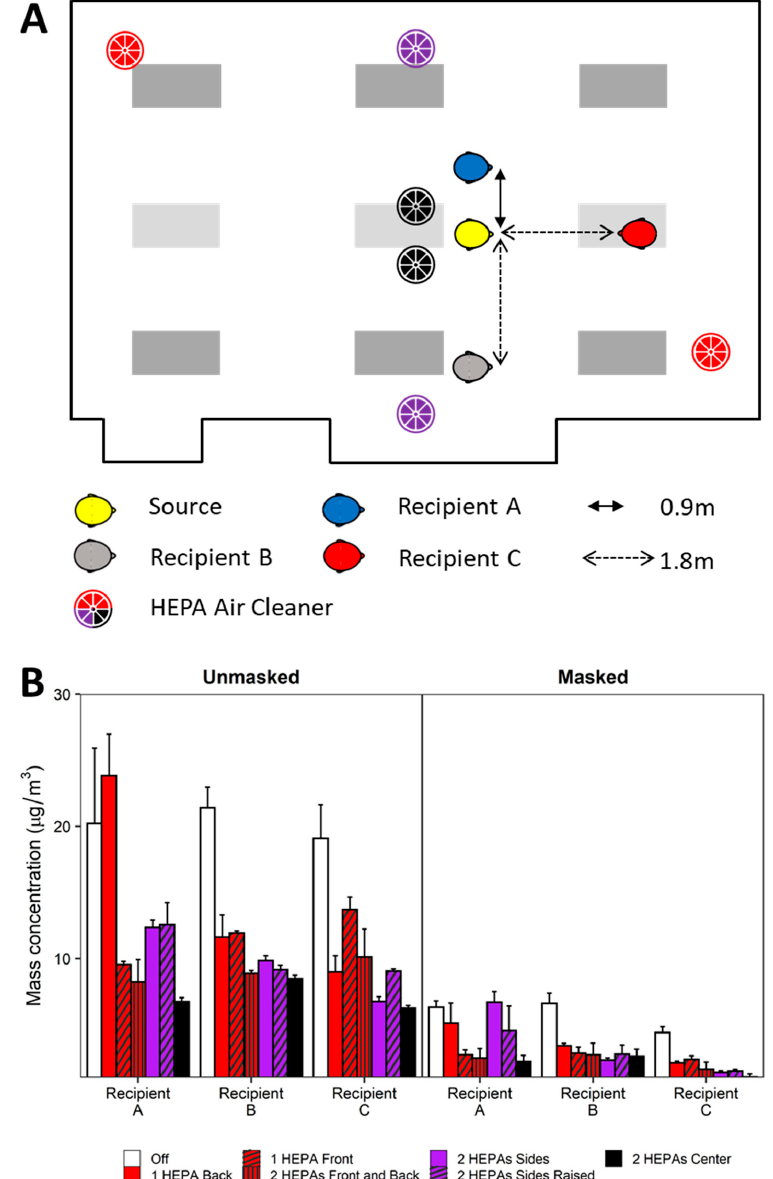
Figure 5. HEPA air cleaner augmentation. ( A ) Composite diagram showing breathing simulator in the second-row configuration and HEPA air cleaner placement scenario under HVAC system setpoint at 2 ACH. ( B ) Mean mass concentration measured at the Recipient breathing simulators for unmasked and universal masking experiments. Data are presented as the mean of four independent experiments. Error bars represent one standard deviation.